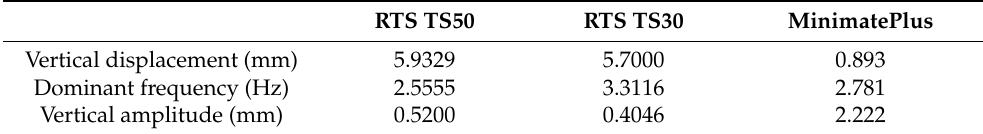
Table 3. Analysis—comparison of results.